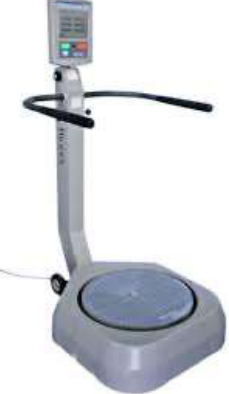
Figure 1. Biodex Balance System platform.